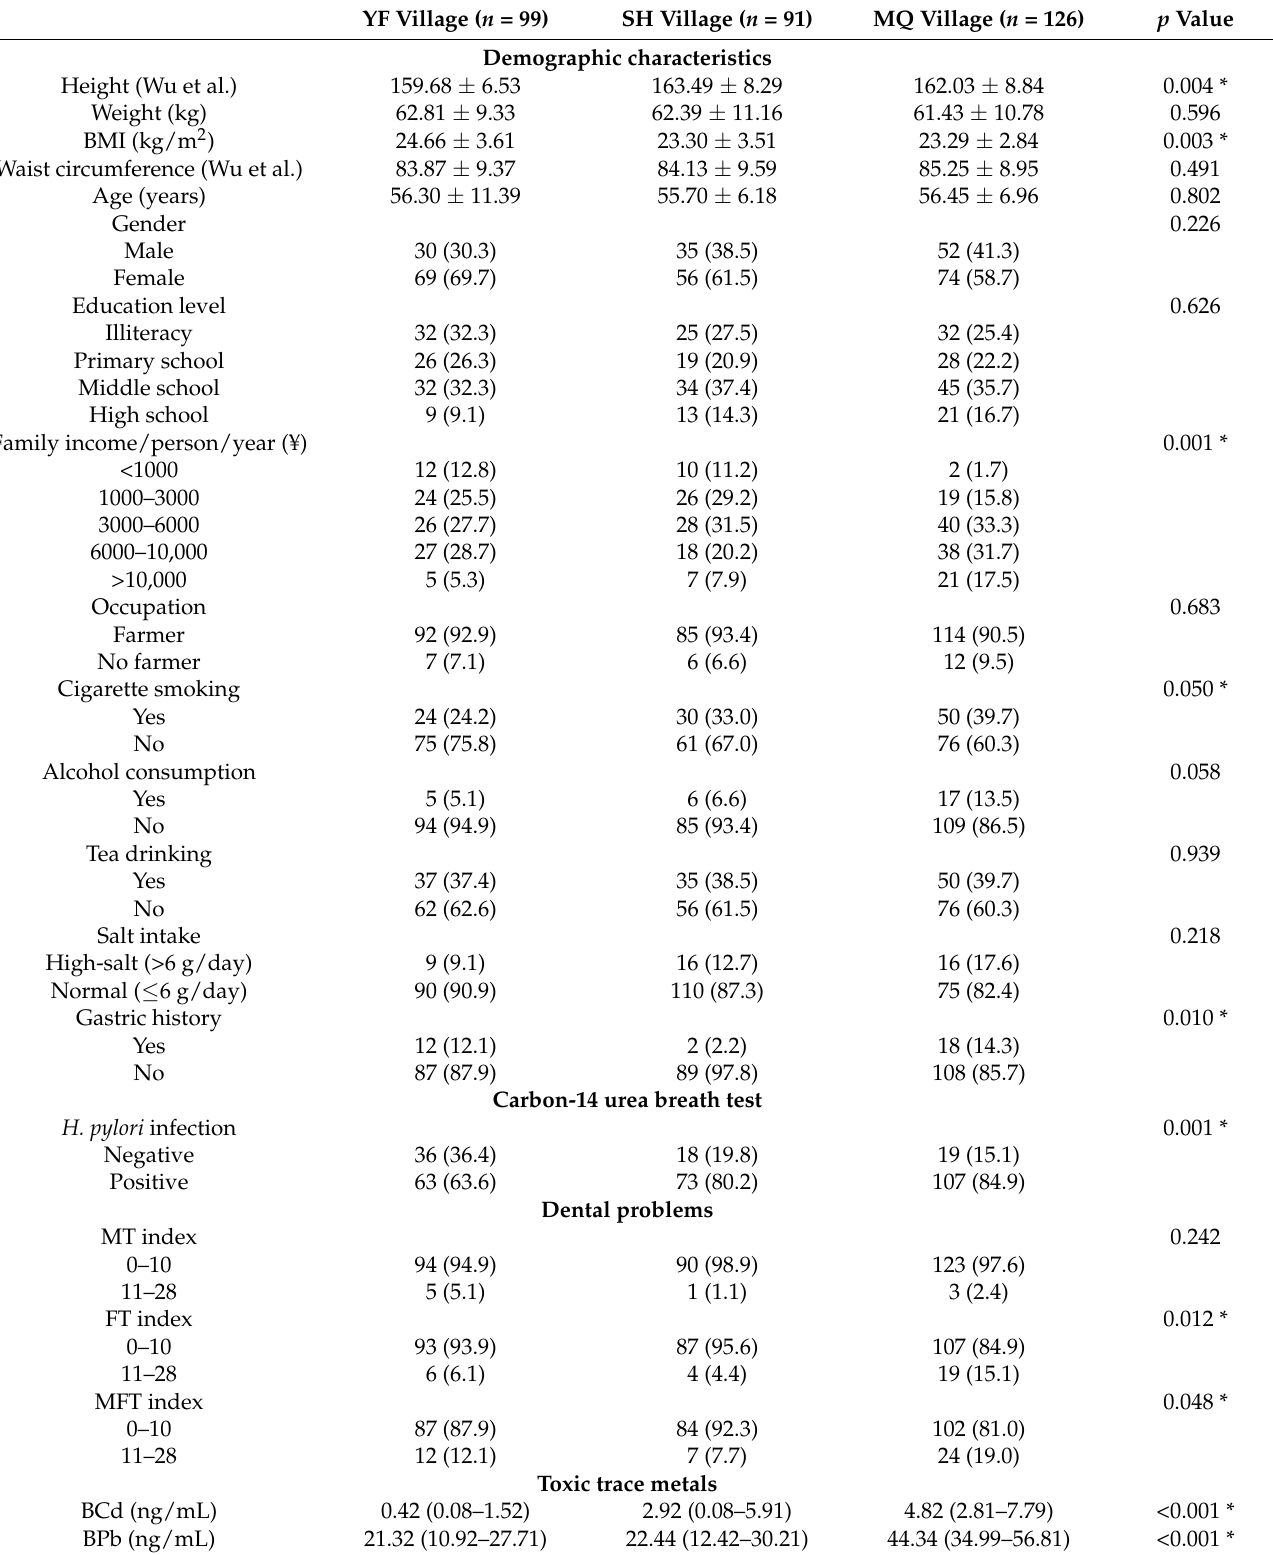
Table 1. Characteristics of the study population in the different